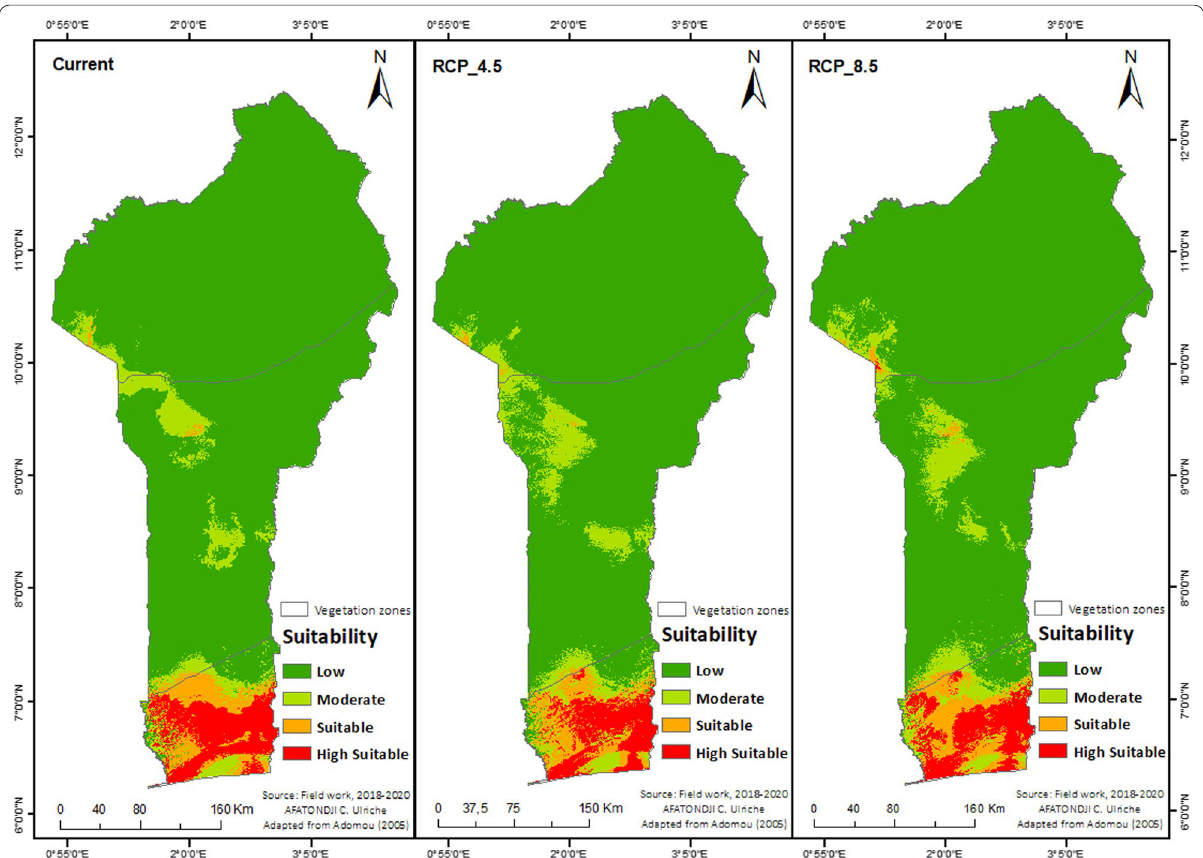
Fig. 8 Map of current and future potential suitable habitats for Goat Type I under RCP 4.5 and RCP 8.5 across Benin. RCPs 4.5 and 8.5 are climate scenarios of 4.5 W m − 2 and 8.5 W m − 2 ,